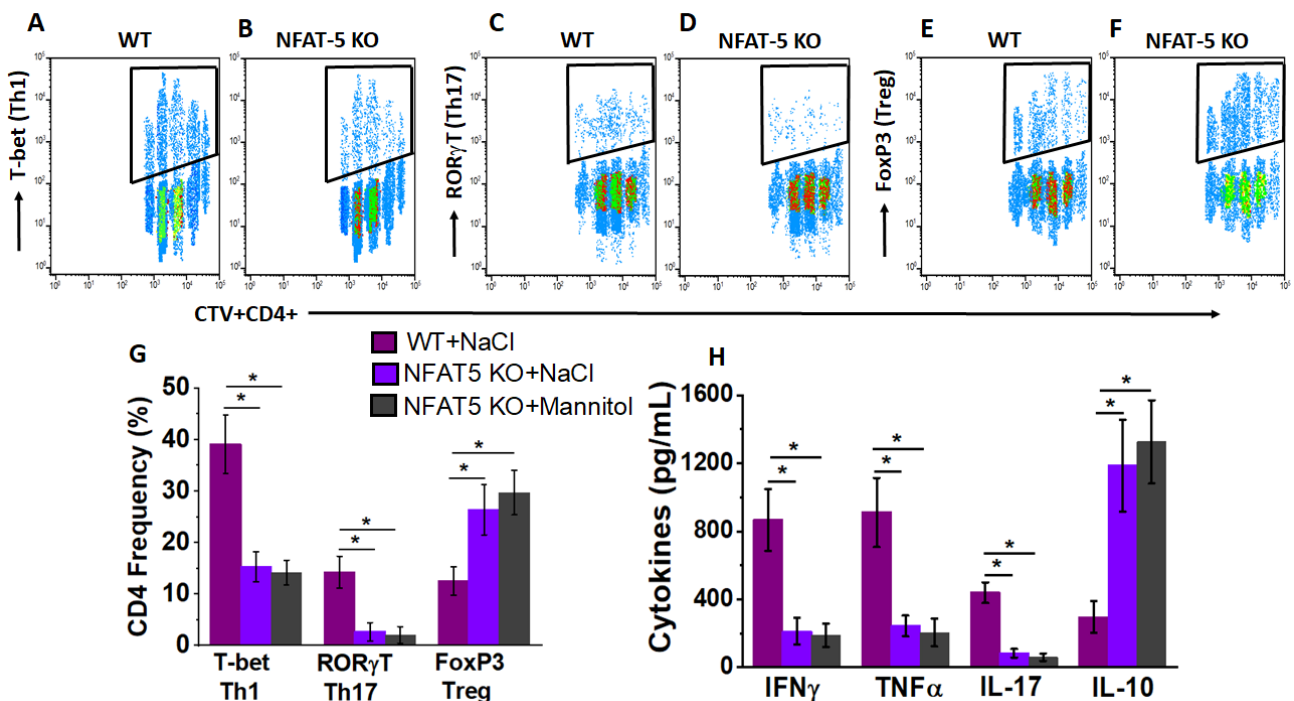
Figure 8. In vivo tracking and localization of ex vivo expanded CD4+T cells. Analysis of Tbet ( A , B ), ROR γ T ( C , D ) and FoxP3 ( E , F ) in CTV stained CD4+T cells injected on day of tumor-bearing wild-type mice. High salt expanded CD4+T cells for three stimulation cycles obtained from DLNs of wild type ( A , C , E ) and CD4+NFAT5-KO ( B , D , F ) were analyzed for tumor localization. ( G , H ) Th-phenotypic frequencies ( G ) and cytokine expression ( H ) of the tumor localized ex vivo expanded CD4+T cells obtained from high salt treated wild-type mice (magenta), high salt treated (purple), and equimolar mannitol treated CD4+NFAT5-KO mice (grey). Data obtained from n = 3 in each cohort and presented as mean ± SEM; (*) p < 0.05.